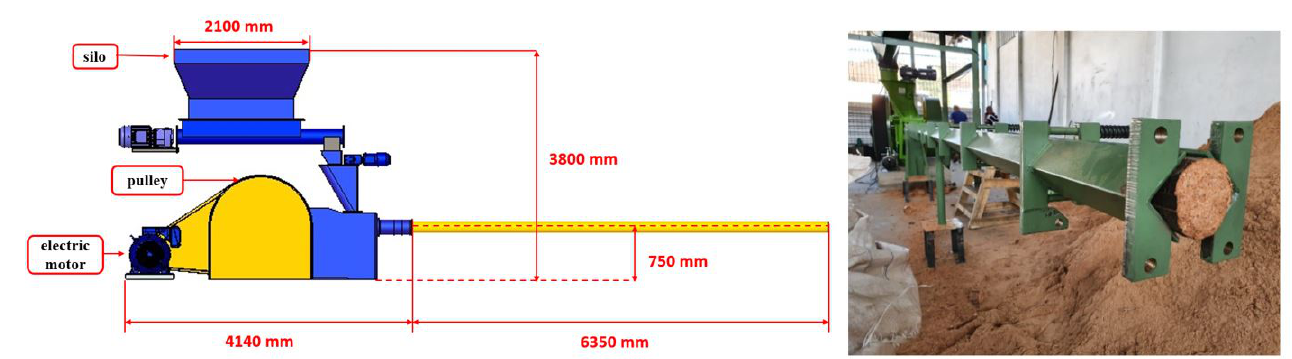
Figure 6. Briquetting machine.